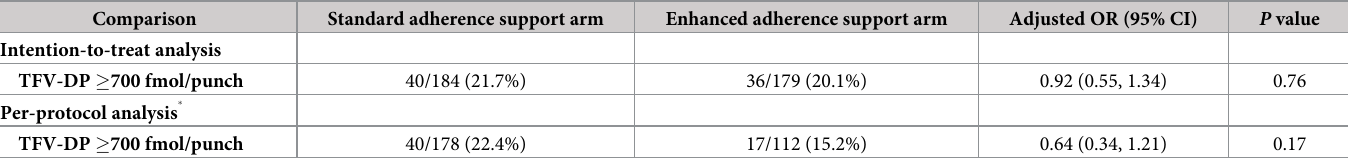
Table 3. Analysis of DBS TFV-DP concentration ( � 700 vs. < 700 fmol/punch) at month 6 among PrEP initiators by adherence support arm.